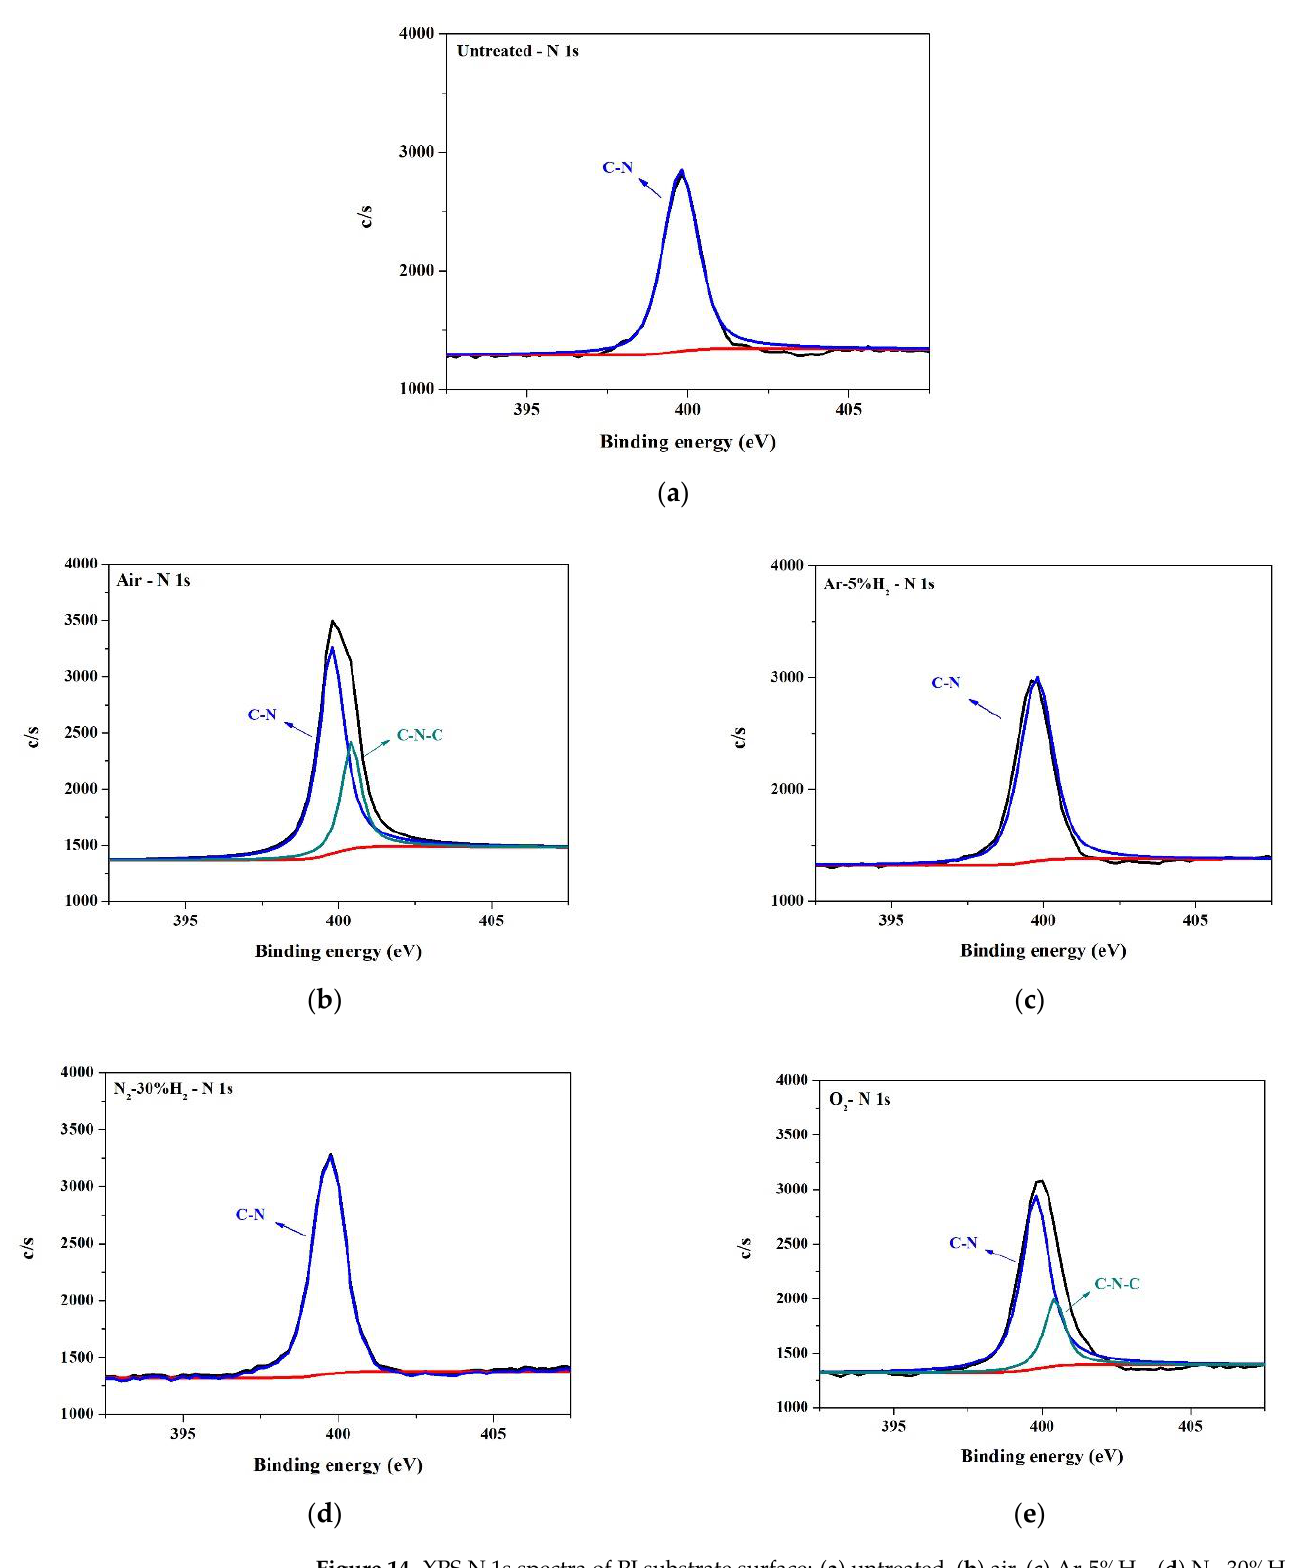
Figure 14. XPS N 1s spectra of PI substrate surface: ( a ) untreated, ( b ) air, ( c ) Ar-5%H 2 , ( d ) N 2 -30%H 2 , and ( e ) O 2 .